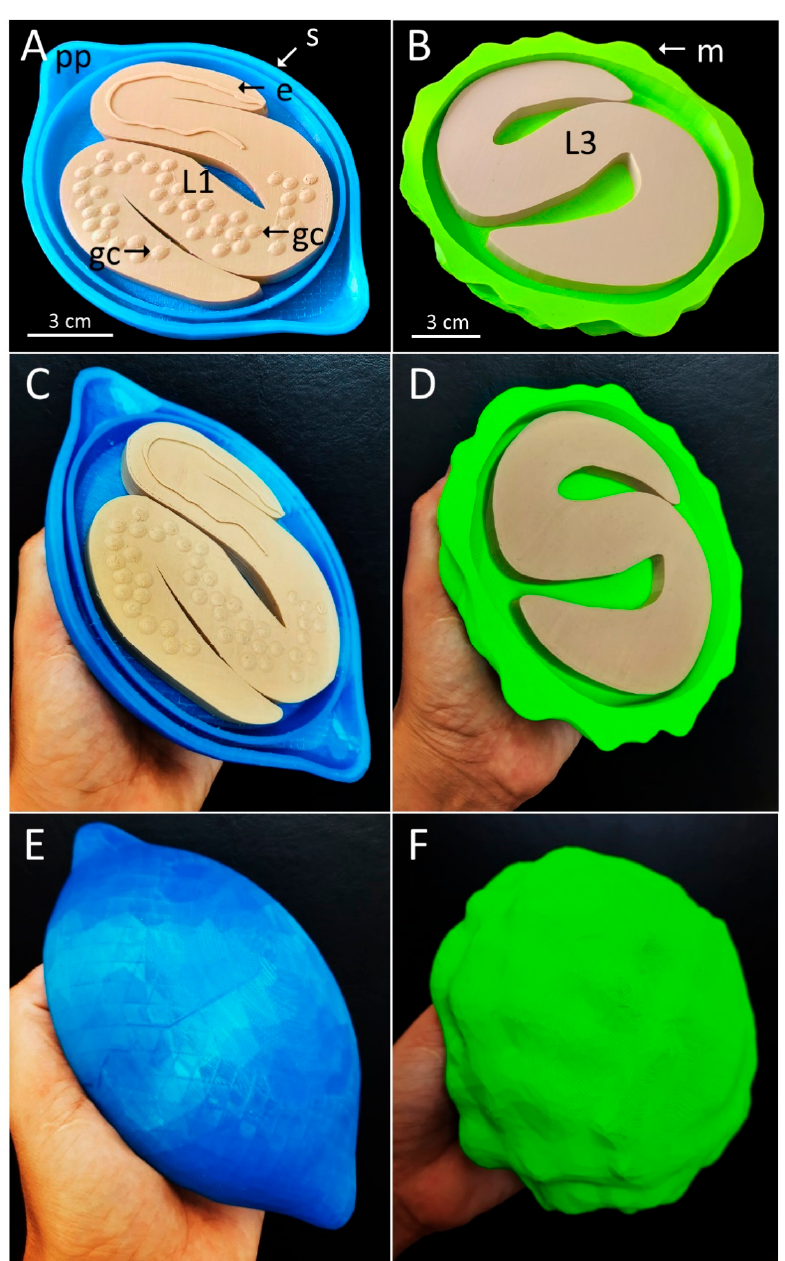
Figure 3. Photographs showing different sides of the printed egg models. ( A , C , E ): Trichuris muris egg (blue) measuring 20 cm × 12 cm, showing the polar plugs (pp), smooth eggshell (s), first-stage larvae (L1), esophagus (e), and germ cells (gc). ( B , D , F ): Ascaris lumbricoides egg (green) measuring 17 cm in diameter, showing third-stage larvae (L3) and the texture of the mamillated layer (m) on the outer surface of the egg model.